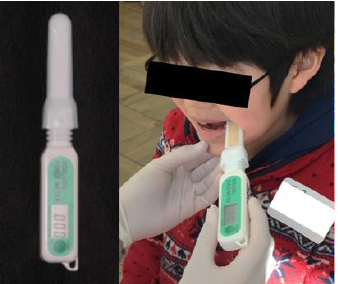
Figure 8. Occlusal force measurement. The occlusal force was measured using GM10 (Nagano Keiki Co., Ltd., Tokyo, Japan). The subjects were seated in the Frankfurt horizontal plane parallel to the floor. The sensor was placed in the maxillary first molar, and the occlusal force was measured. Lip closure force (LCF) was measured using Lip De Cum LDC-110R ® (Cosmo Instru- ments Co., Ltd., Tokyo, Japan), shown in Figure 9. The analyzer consists of a sensor with a lip adapter and a digital display [20]. The lip closure force analyzer (Lip De Cum ® ) was set up with a lip holder (Ducklings ® ) placed on the sensor. The lip closure force was measured while the patient was seated (with the FH plane parallel to the floor plane) and was instructed to close the upper and lower lips with maximum force. The LCF was measured three times, and the highest value was recorded for each subject.